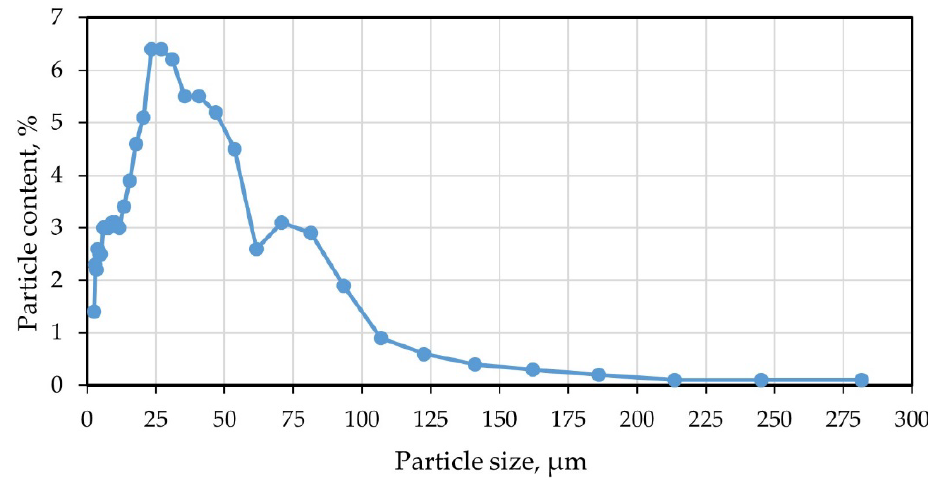
Figure 1. Granulometric composition of microsilica. Table 3. Characteristics of raw